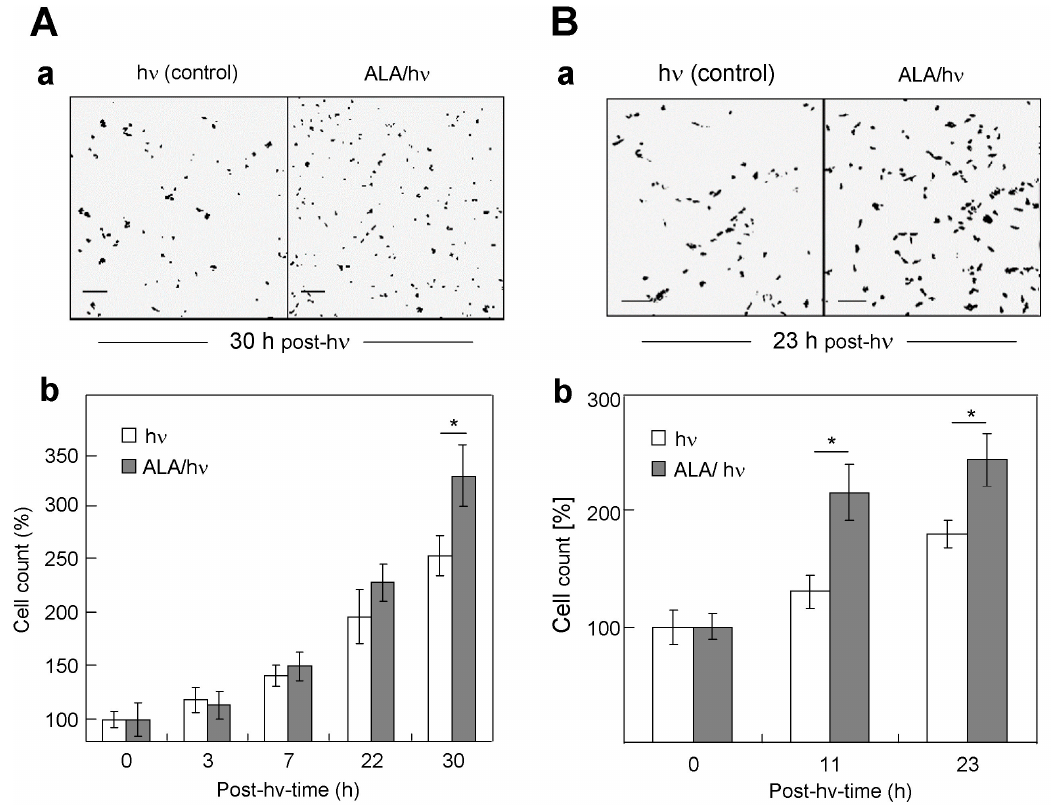
Figure 2. Accelerated proliferation of surviving ALA/light-targeted MDA-MB-231 cells ( A ) and bystander counterparts ( B ). ALA-treated cells and non-treated bystanders were irradiated as described in Figure 1, after which surviving (still attached) ALA/light-challenged cells, now in 10% serum-containing medium, were monitored for proliferation rate compared with light-only (h ν ) controls. ( a ) Bright-field microscopic images of targeted cells and controls 30 h after irradiation; each bar represents 500 µm; ( b ) Plot of targeted and control cell counts determined by Image-J analysis of microscopic images as in panel ( a ); * p < 0.01 compared with light-only controls. ( B ) Bystander responses: ( a ) bright-field images 23 h after irradiation; ( b ) plot of cell counts assessed by Image-J analysis over 23 h of post-h ν incubation; each bar represents 500 µm. Plotted values in ( A ) and ( B ) are means ±SEM ( n = 3); * p < 0.01 vs. light-only controls.